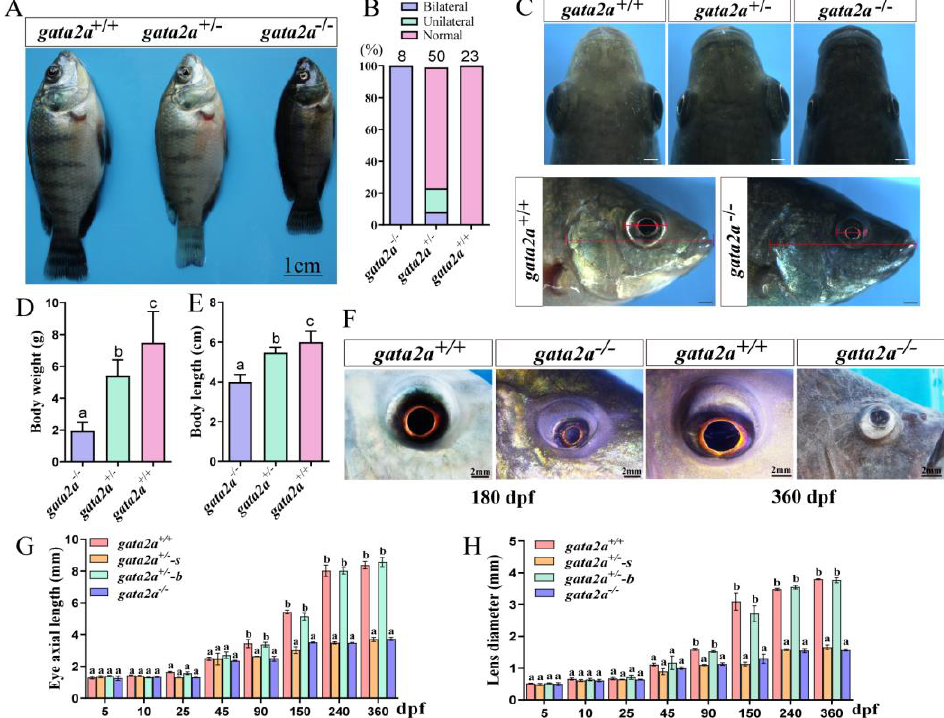
Figure 3. Morphological analysis of tilapia gata2a mutants at 90 dpf. ( A ) Morphology of gata2a mutants. ( B ) Proportions of the fish with microphthalmia in the F2 generation. ( C ) Eyes morphology of the gata2a mutants at 90 dpf. The presence of small eyes on the left or right side is random in gata2a +/ − fish. ( D , E ) Body weight and body length (sample size: homozygous mutants, n = 8, heterozygous mutants, n = 50, wt, n = 23). ( F ) Eye morphology of gata2a homozygous mutants at 180 and 360 dpf. ( G , H ) Eyes axial length and lens diameter. Data are expressed as the mean ± SD. One-way ANOVA was performed followed by Tukey’s test. Different letters above the error bar indicate significant differences at p < 0.05. dpf: day post fertilization. “ gata2a +/ − -s” and “ gata2a +/ − -b” represents eyes from gata2a heterozygous mutants with unilateral micropgthalmia (s, small eye; b, big